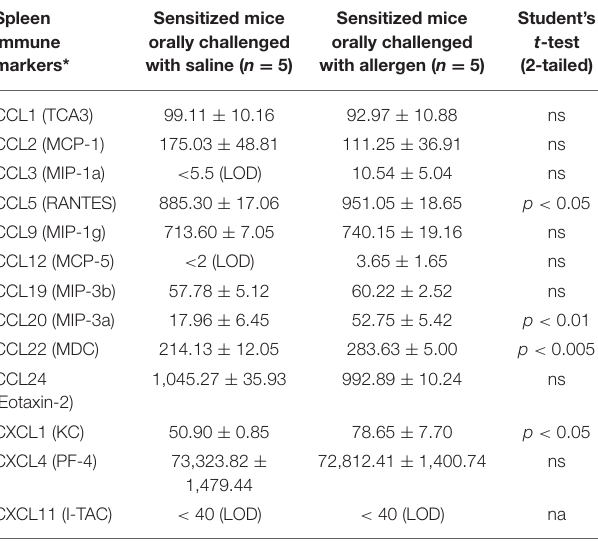
TABLE 2 | Identification of spleen chemokines that are increased upon oral allergen but not saline challenge in durum wheat sensitized mice. Spleen